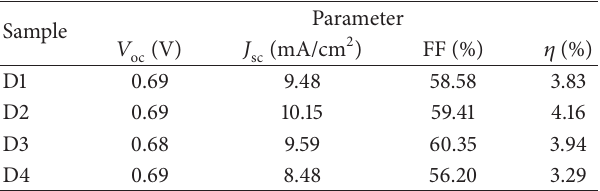
Table 2: Photocurrent-voltage data of the chitosan sol-based